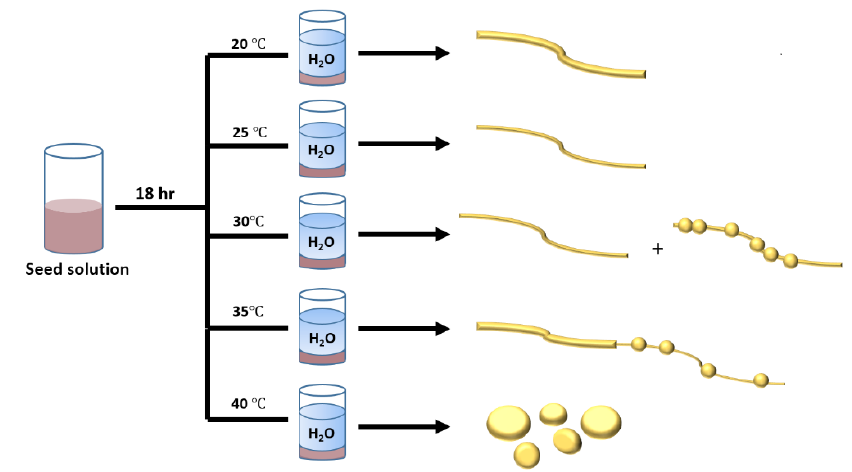
Figure 2. Schematic summarising the synthesis and products following dilution after aging at various temperatures for 18 h.